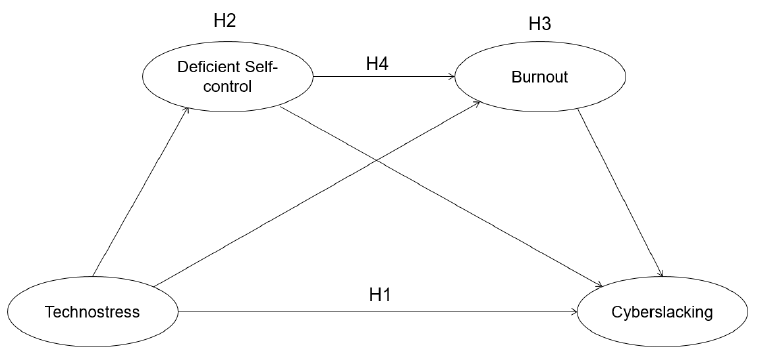
Figure 1. Hypothetical model of the relationship between technostress, deficient self-control, burnout and cyberslacking.